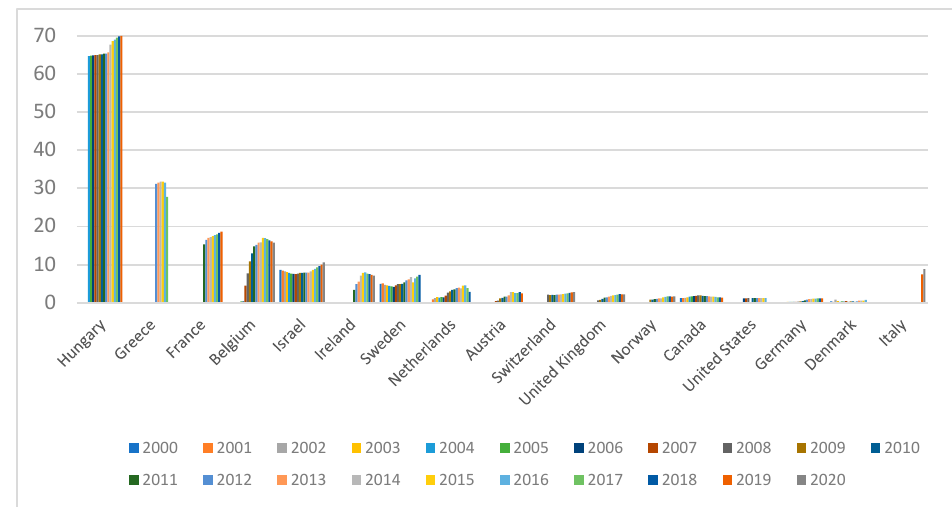
Figure 9. The share of doctors from Romania in total foreign-trade doctors (%).